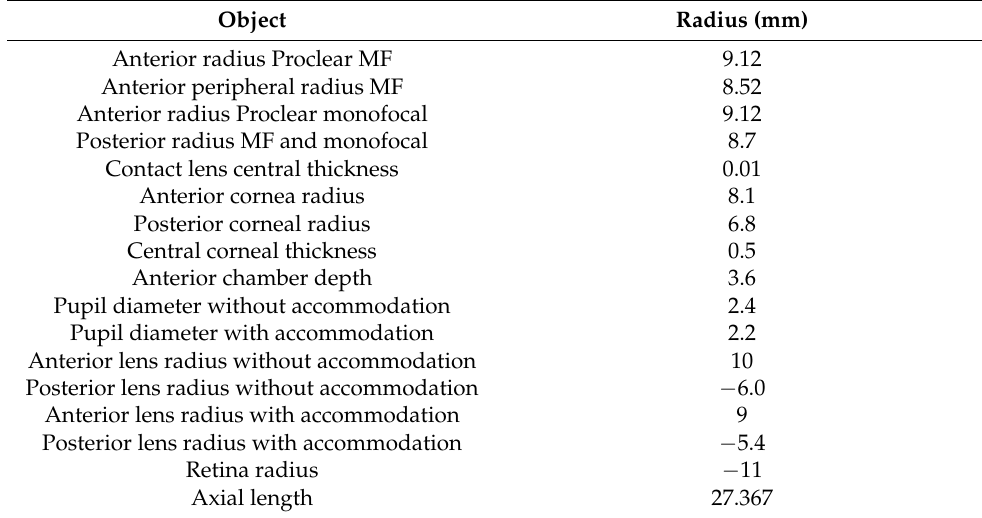
Table 1. Dimension of the data used for the ray-tracing model with the software OpTaliX. The complete description of the model is in the supplemental